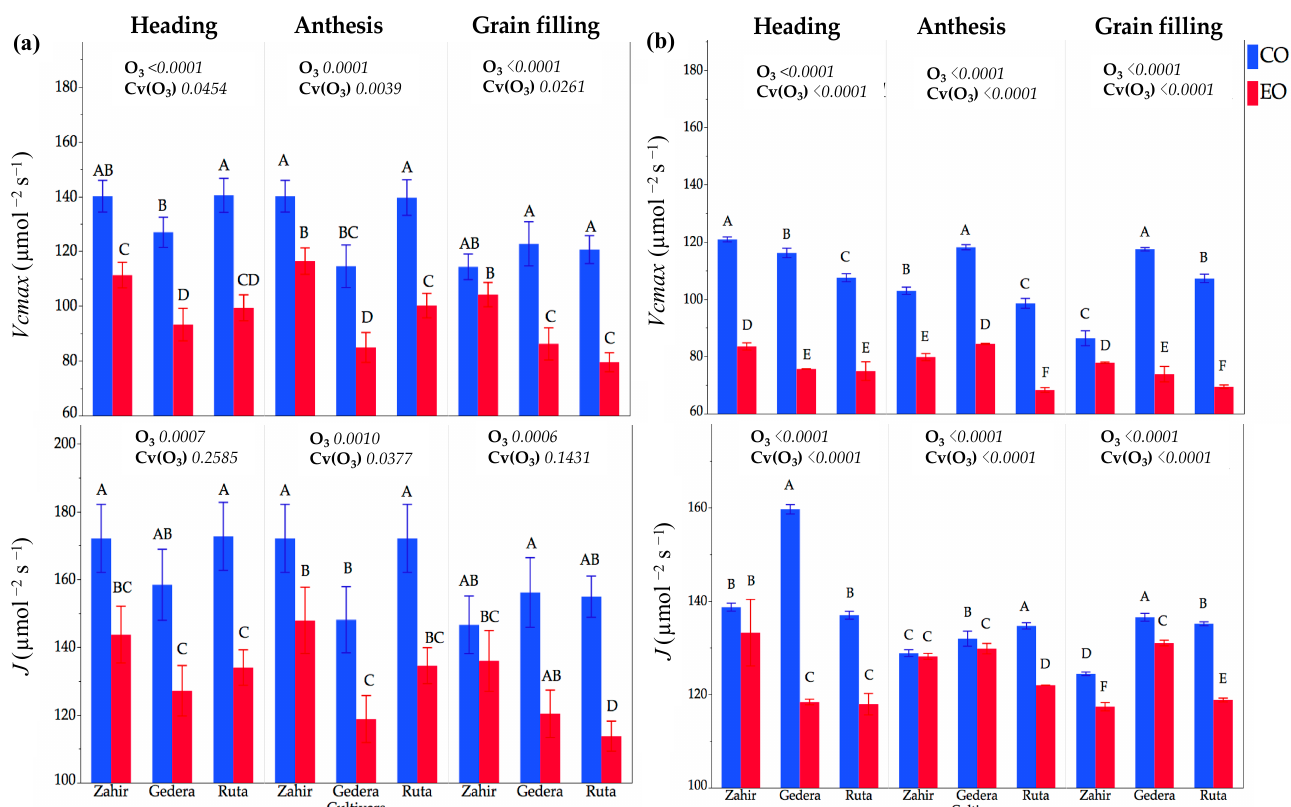
Figure 8. OTC experiment. ( a ) season I and ( b ) season II represents maximum carboxylation rate ( Vcmax ) and electron transport rate ( J ) under O 3 enriched OTC (EO) and corresponding controls (CO) during season I and season II (mean ± SE, n = 3). Different letters above the bars indicate a significant difference ( p < 0.05) by Student’s t -test. p -values of factors O 3 exposure (O 3 ) and cultivar within O 3 effect Cv(O 3 ) for parameters Vcmax and J by ANOVA are also shown.